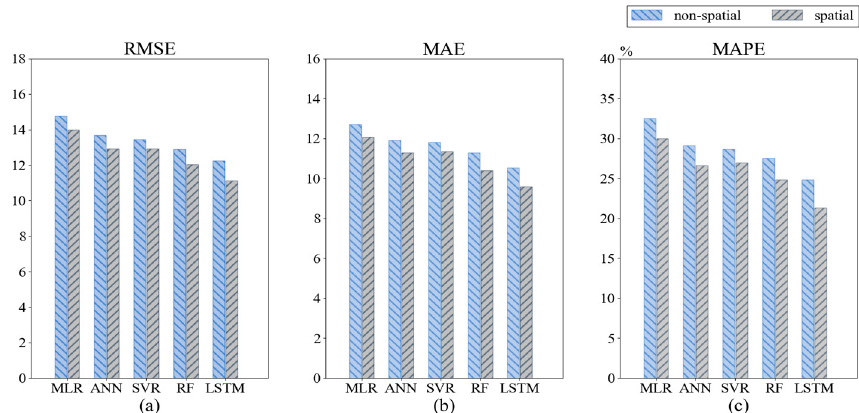
Figure 5. Performances of prediction models using different baselines.